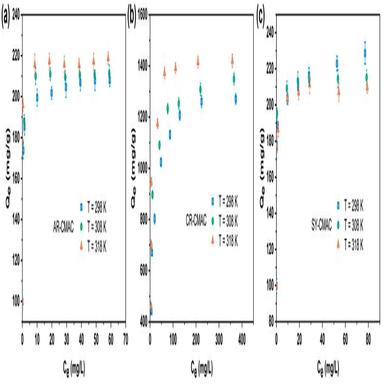
Experimental isotherms of the adsorption of dyes (a) AR, (b) CR and (c) SY on CMAC at 298–318 K, pH = 5 (AR, SY) and pH = 6 (CR).